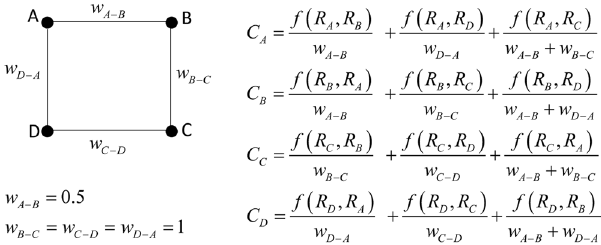
Figure 2. Regular network: harmonic centrality